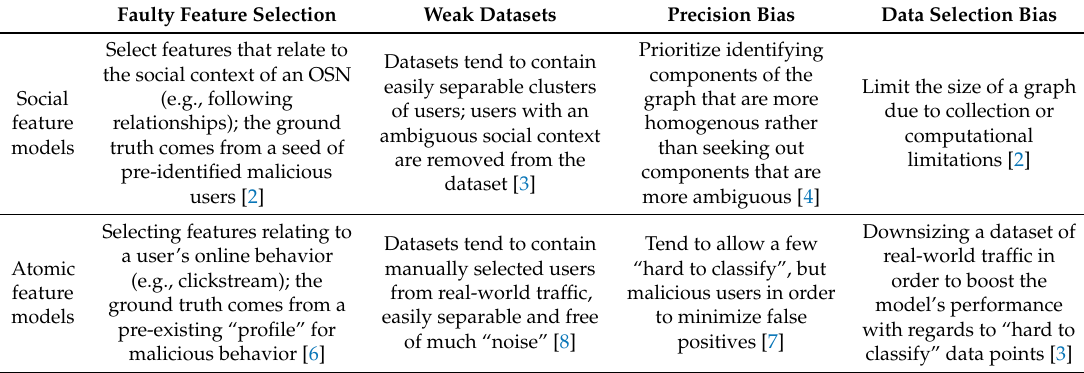
Table 1. Primary types of models, along with their common research